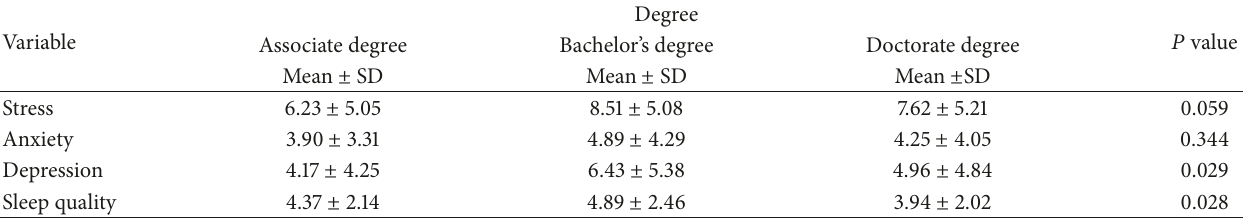
Table 3: Comparison of the mean scores of stress, anxiety, depression, and sleep quality among students based on their studying grade. Variable